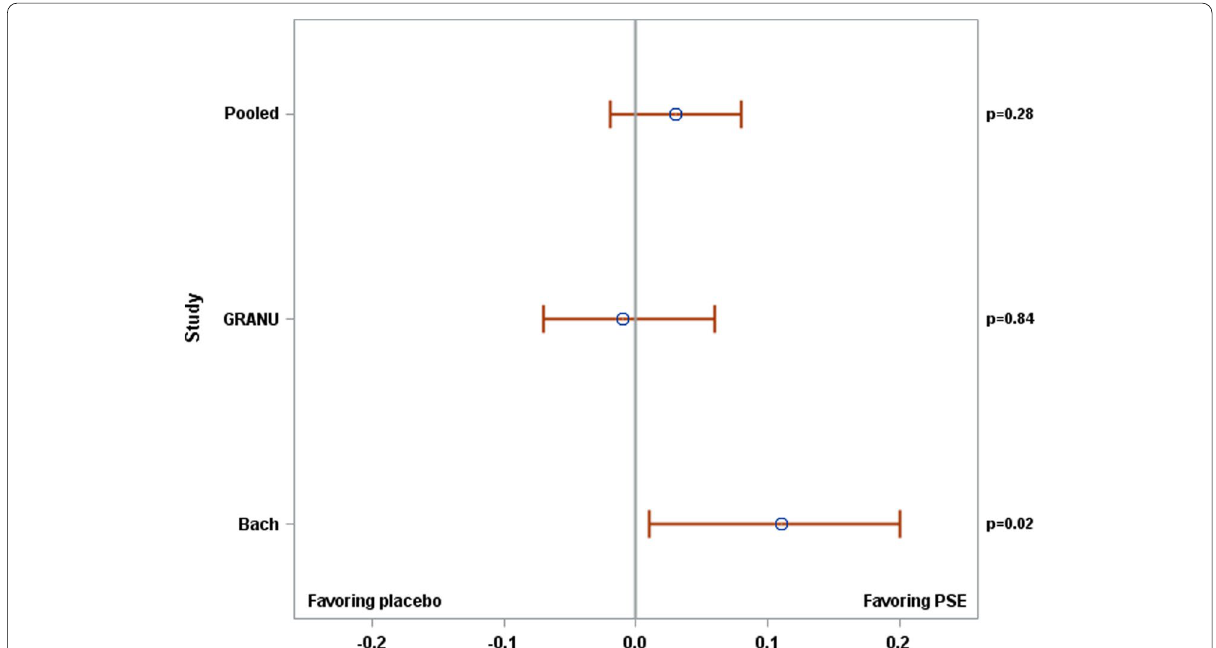
Fig. 3 Forest plot showing the difference (with 95% CI) between treatments (PSE minus placebo) in IPSS response rates after 12 months of treatment; ITT set using LOCF. PSE pumpkin seed soft extract. The response rate is the number of responders divided by the total number of patients treated in the respective group